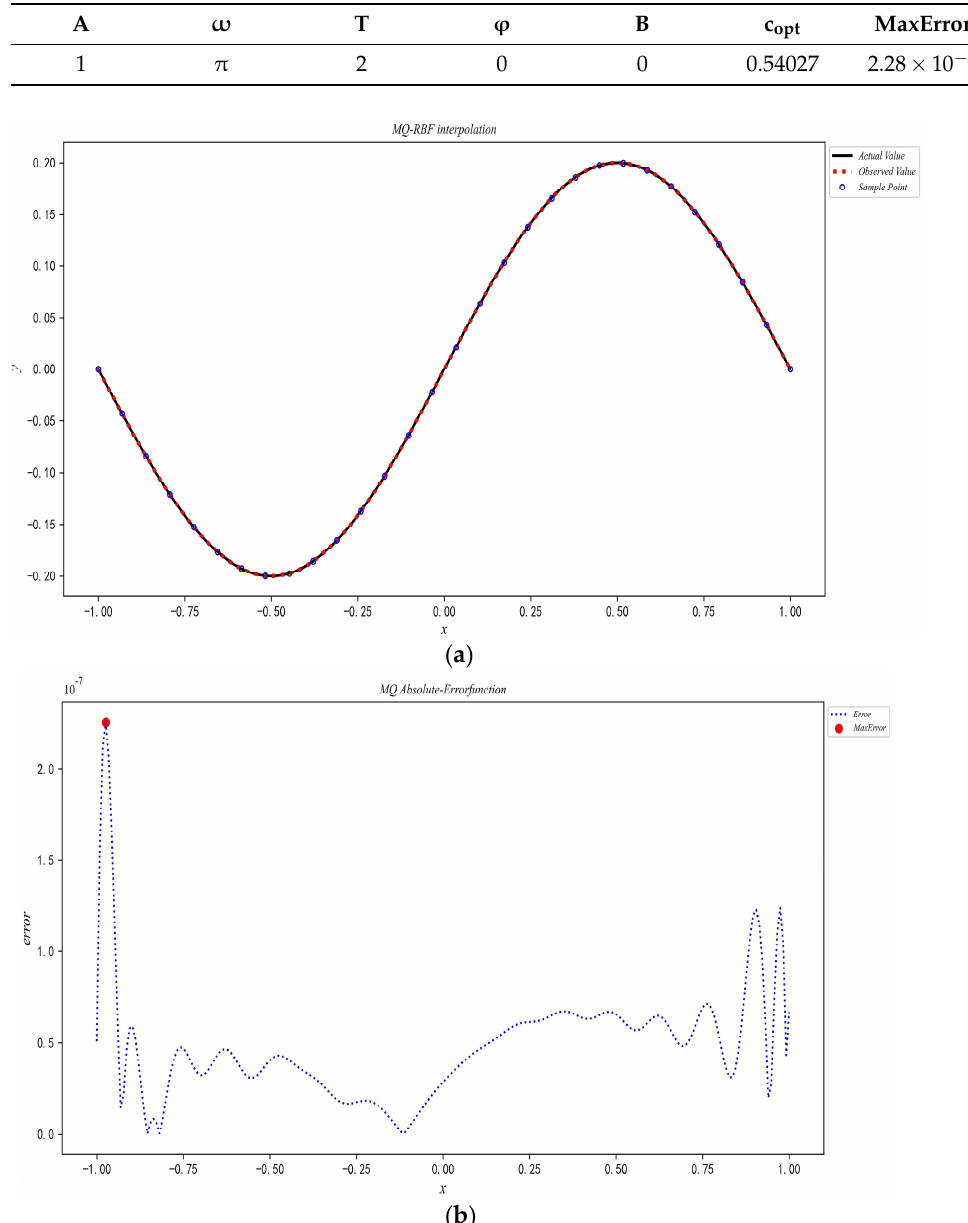
Figure 2. Diagrams of interpolation results of Function (6): ( a ) Interpolation effect diagram, ( b ) Interpolation absolute error diagram.